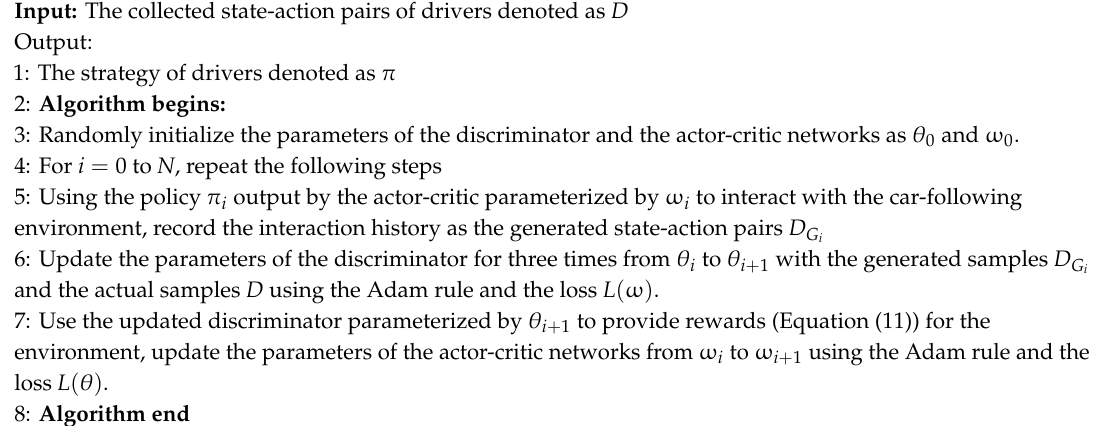
Algorithm 1: Algorithm for modeling drivers’ car-following